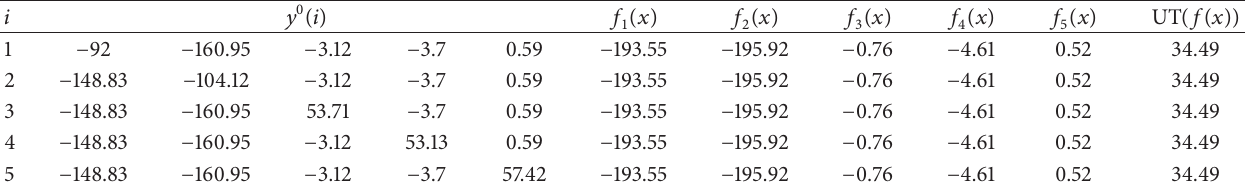
Table 8: The obtained efficient points according to the perturbed reference points in Example 2.